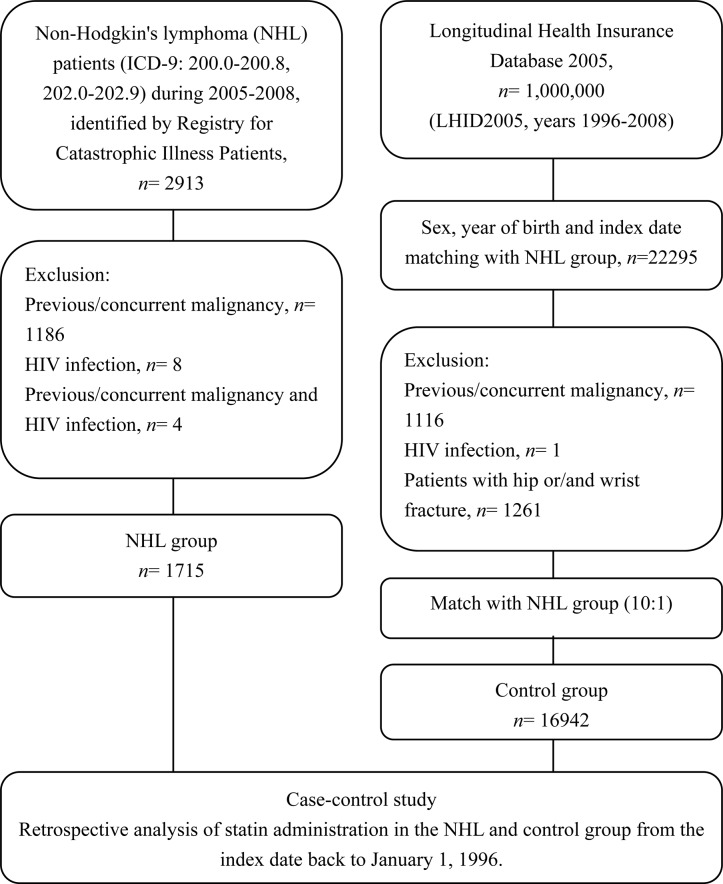
Flow chart summarizing the data acquisition for the NHL and control groups.